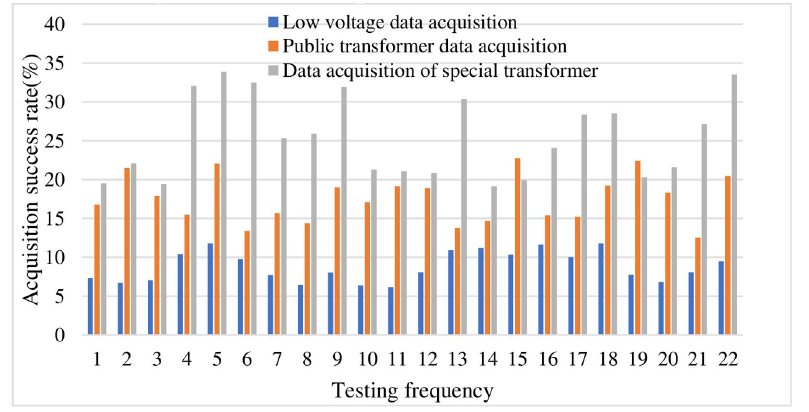
Fig 2. Shipping time.